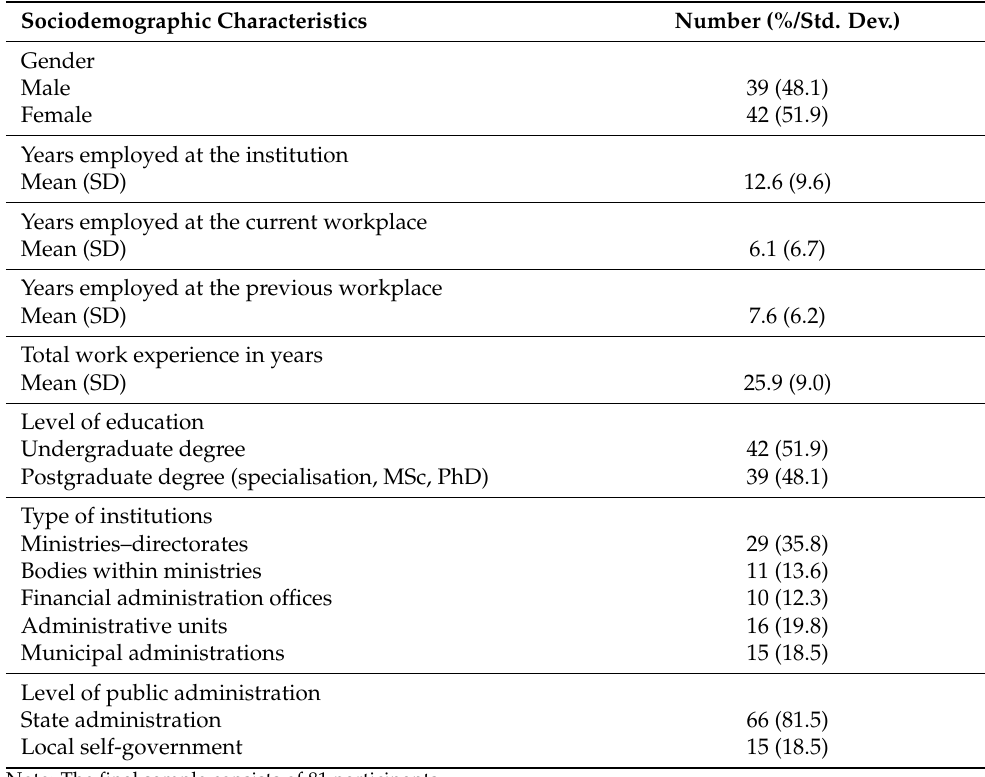
Table 2. Sociodemographic characteristics of the survey respondents and institutions. Sociodemographic Characteristics Number (%/Std.